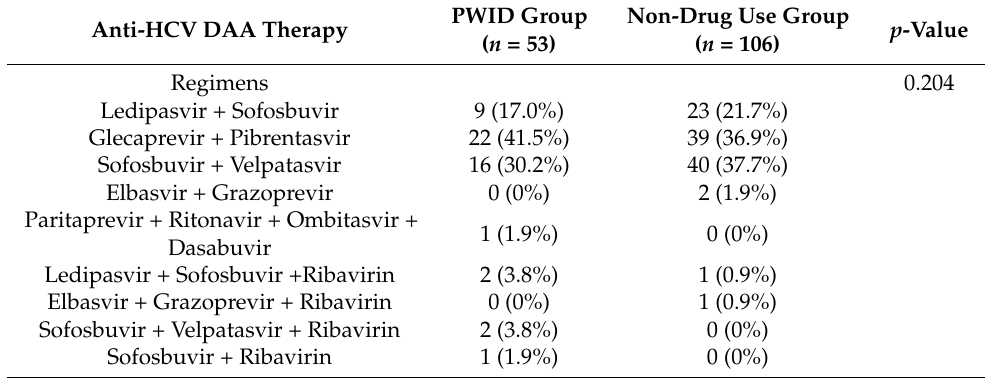
Table 2. DAA regimens for HCV infection in the PWID and non-drug user groups. Anti-HCV DAA Therapy